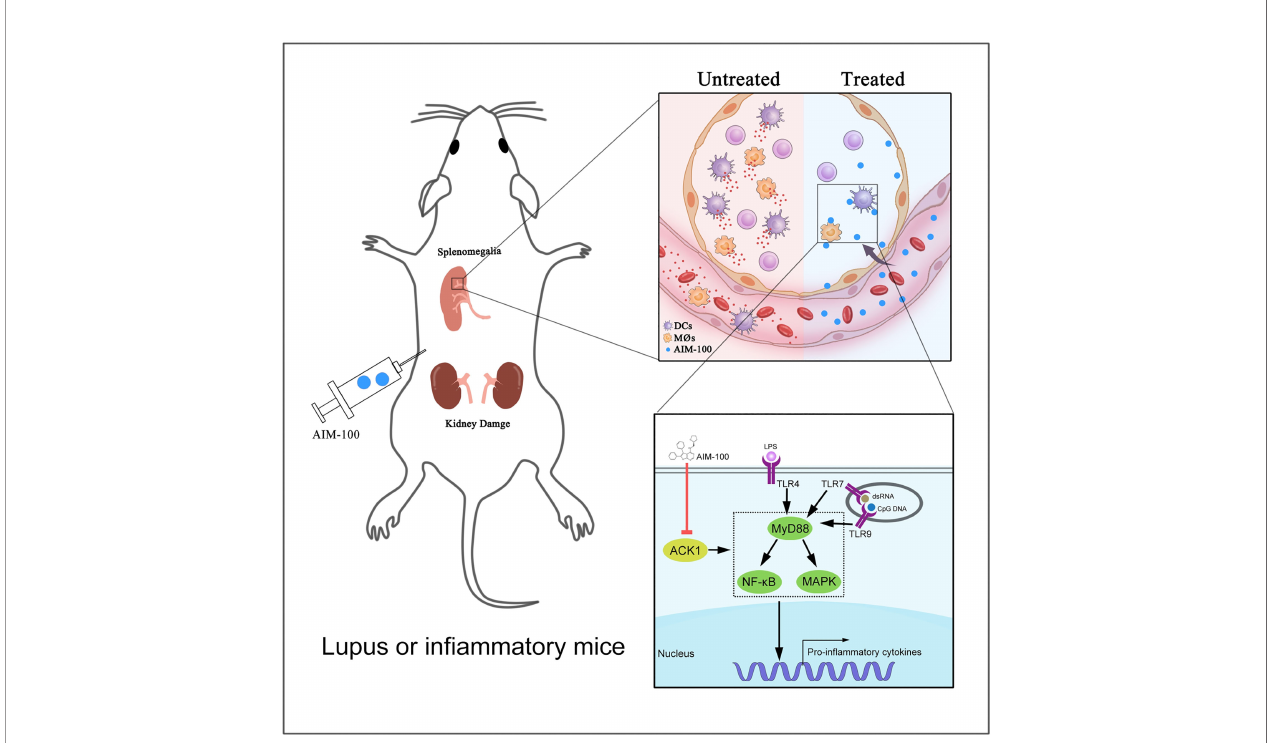
FIGURE 8 | A mechanistic model of ACK1 participates in the pathogenesis of in fl ammation and autoimmunity by promoting the activation of TLR signaling pathways. This schematic diagram indicted that ACK1 promotes TLR4/TLR7/TLR9-induced activation of macrophages and DCs, therefore contributes to the pathogenesis of TLR- mediated in fl ammation and autoimmunity; AIM-100, an inhibitor of ACK1, can signi fi cantly inhibit TLR4/TLR7/TLR9-induced activation of macrophages and DCs, and alleviates the TLRs-mediated in fl ammation and